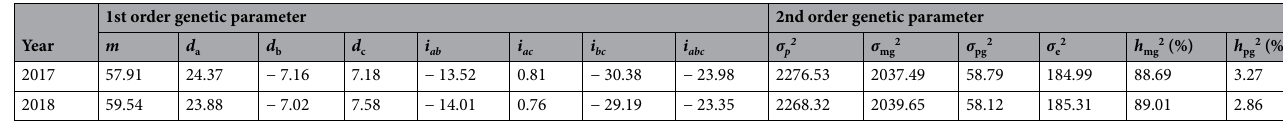
Table 1. Estimates of genetic parameters for SF contents in both years based on G-1 model. m , Mean; d a , d b and d c , Additive effects of the first, second and third major genes; i ab , i ac , i bc , and i abc , The epistatic effect of additive × additive between two and three major genes; σ p 2 , Phenotypic variance; σ pg 2 , Polygenic variance; σ mg 2 , Major gene variance; σ e 2 , Environmental variance; h mg 2 (%), Major gene heritability; h pg 2 (%), Polygenic